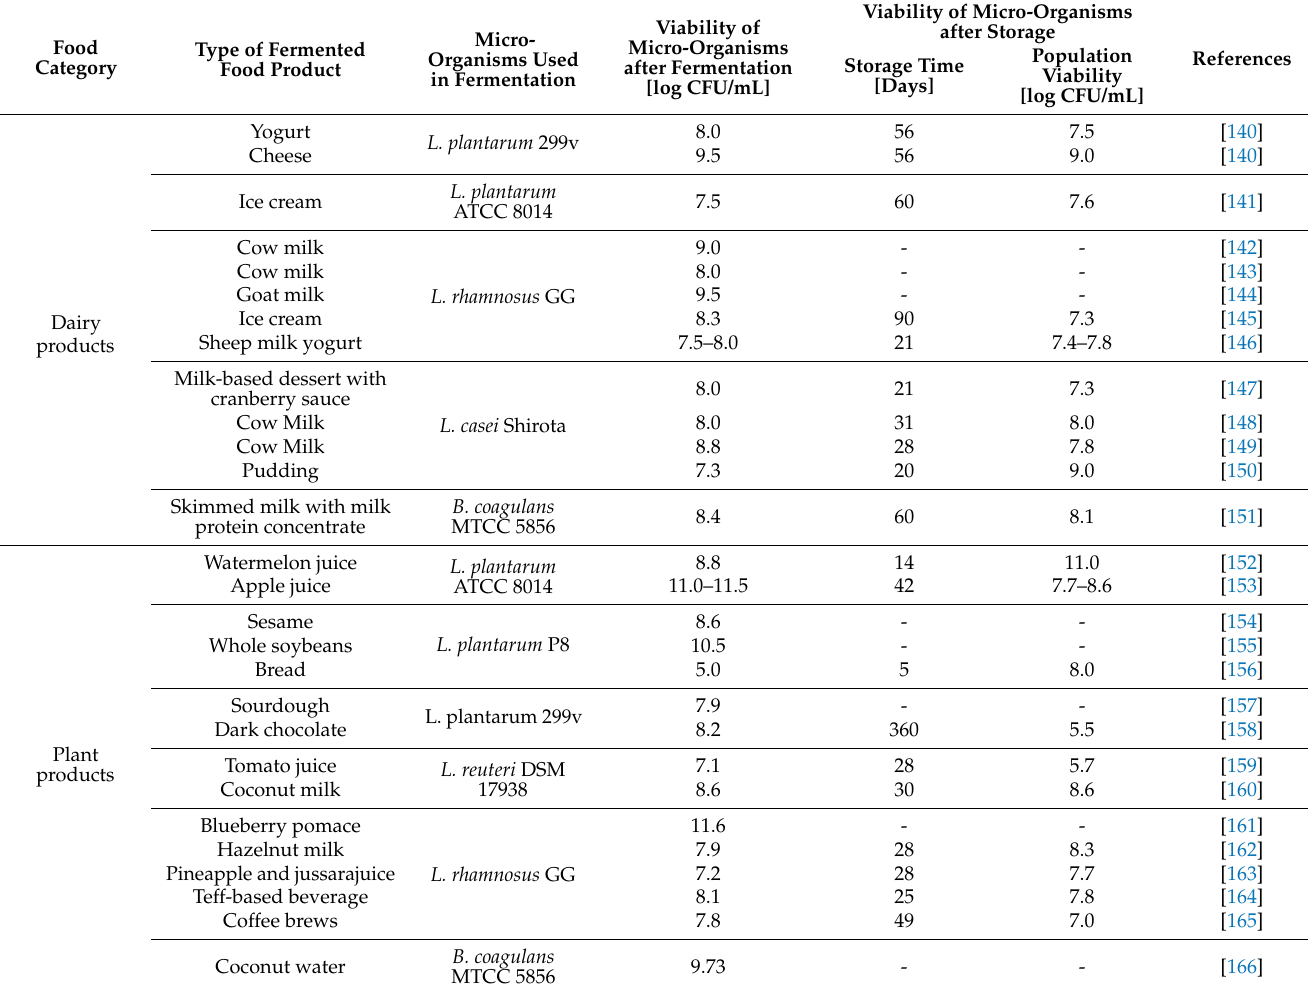
Table 2. The survival of psychobiotics in fermented